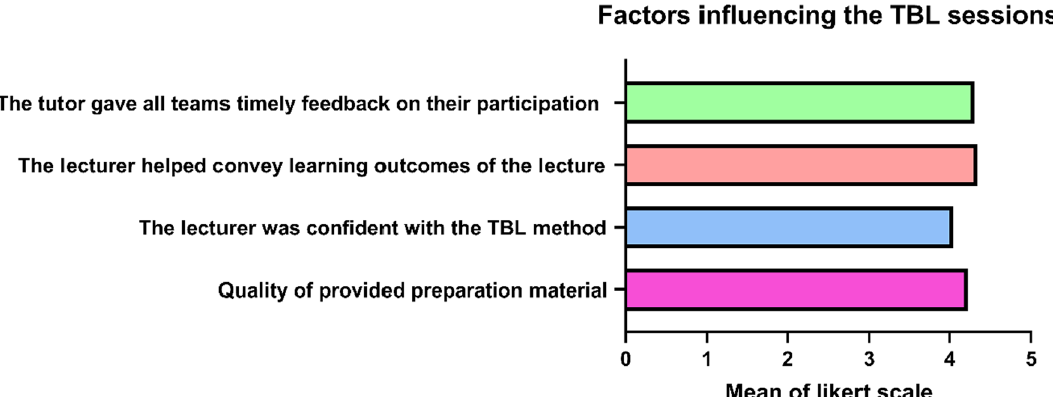
Fig. 4 Different factors influencing the TBL sessions. Data are presented as mean is the